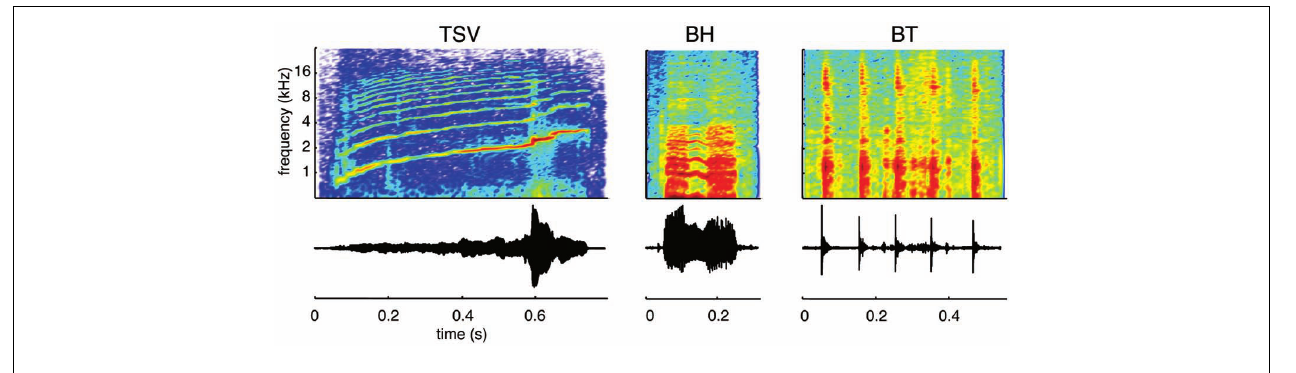
FIGURE 1 |Vocalization waveforms and spectrograms. Three different types of vocalizations were used as acoustic stimuli: a temporally and spectrally varying stimulus (TSV), a broadband with harmonic components stimulus (BH), and a broadband and transient stimulus (BT). All three